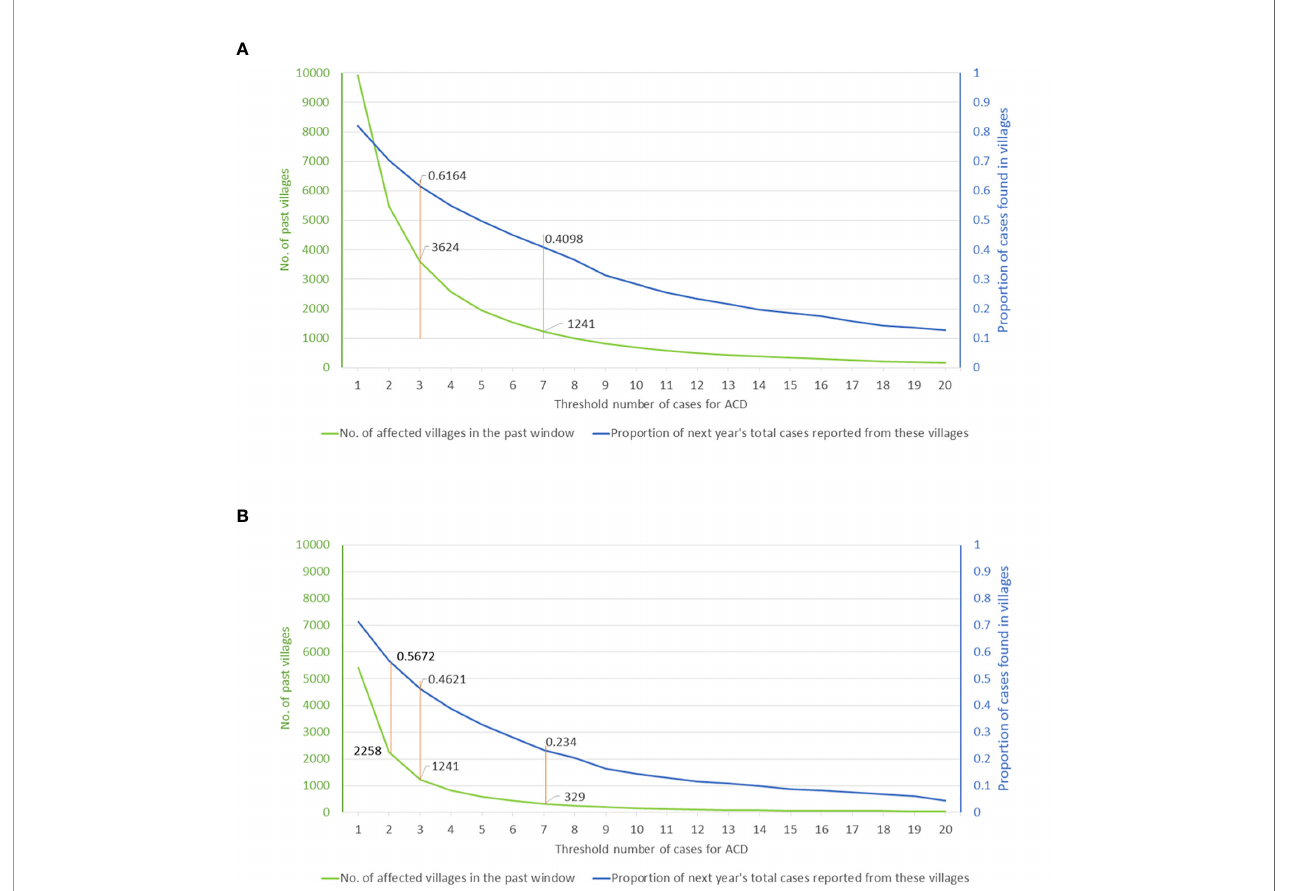
FIGURE 4 | Visceral leishmaniasis case yield in 2019 from village-level targeting of active case detection activities (A) based on cumulative case-load during a 6-year window (2013 – 2018) or (B) the most recent 3-year window (2016 – 2018). The graphs can be used to assess the operational impact of selecting different thresholds of cumulative village case-load from the chosen time window (horizontal axis). The potential yield, de fi ned by the proportion of the cases of 2019 potentially detected, is shown by the blue curve (right-hand vertical axis). The number of targeted villages is shown by the green curve (left-hand vertical